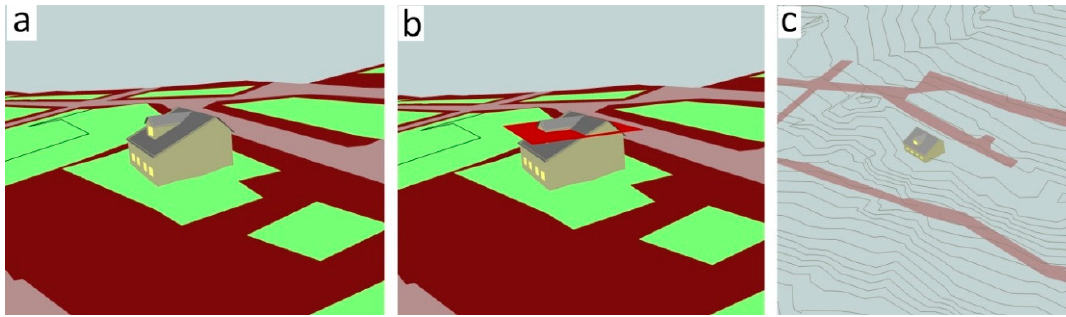
Figure 5. The tested building placed in a location where it is lower than the highest allowed building height ( a ). Green areas are areas where building is allowed, brown areas do not allow building and grey are roads. The maximum allowed building height is added as a red horizontal plane crossing the building in ( b ) as an illustration. ( c ) Contour lines with 1 m contour interval are included to give an overview of the topography in the area.